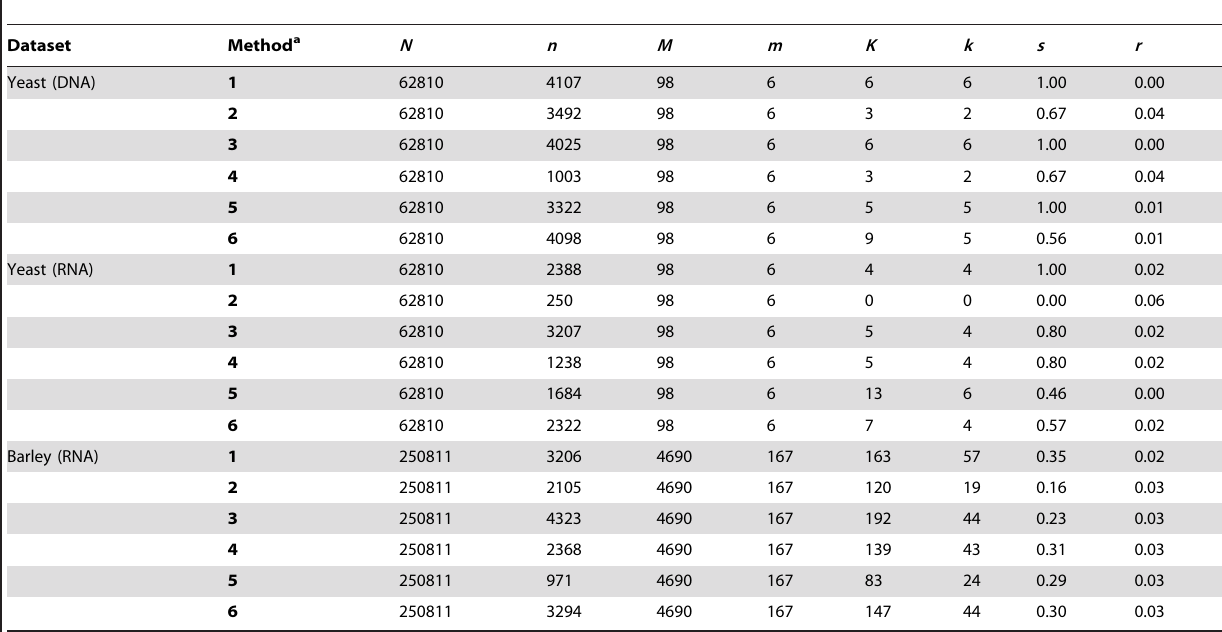
Table 4. The numbers of total probes interrogated on yeast 2.0 and barley 1.0 Affymetrix microarray chips ( N ), SFPs called ( n ), probes sequenced ( M ), probes bearing sequence polymorphism ( m ), probes sequenced and called as SFPs ( K ) and SFPs bearing sequence polymorphisms ( k ), and the estimates for rates of true discovery ( s ) and false negative ( r ).